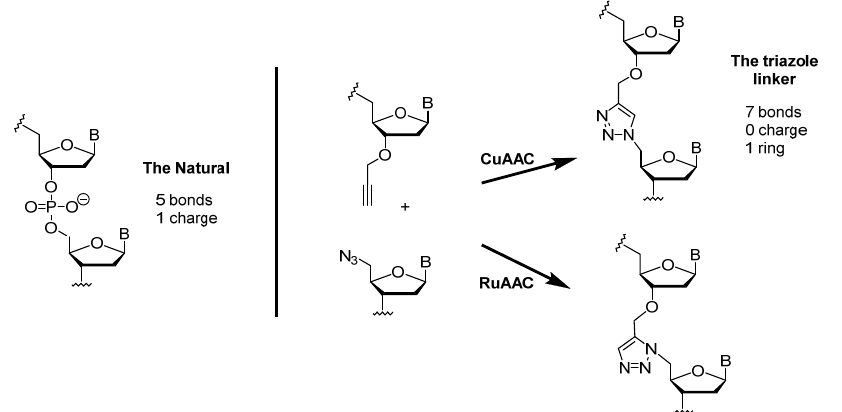
Figure 2. The comparison of the natural internucleotide linkage with a 1,4- or 1,5-disubstituted 1,2,3-triazole linker.